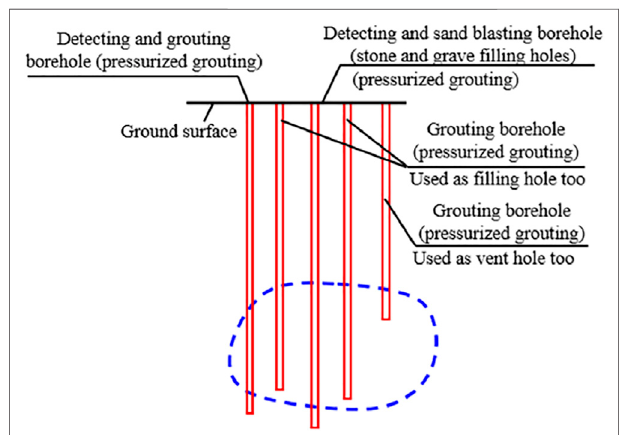
FIGURE 12 | Karst cave treatment